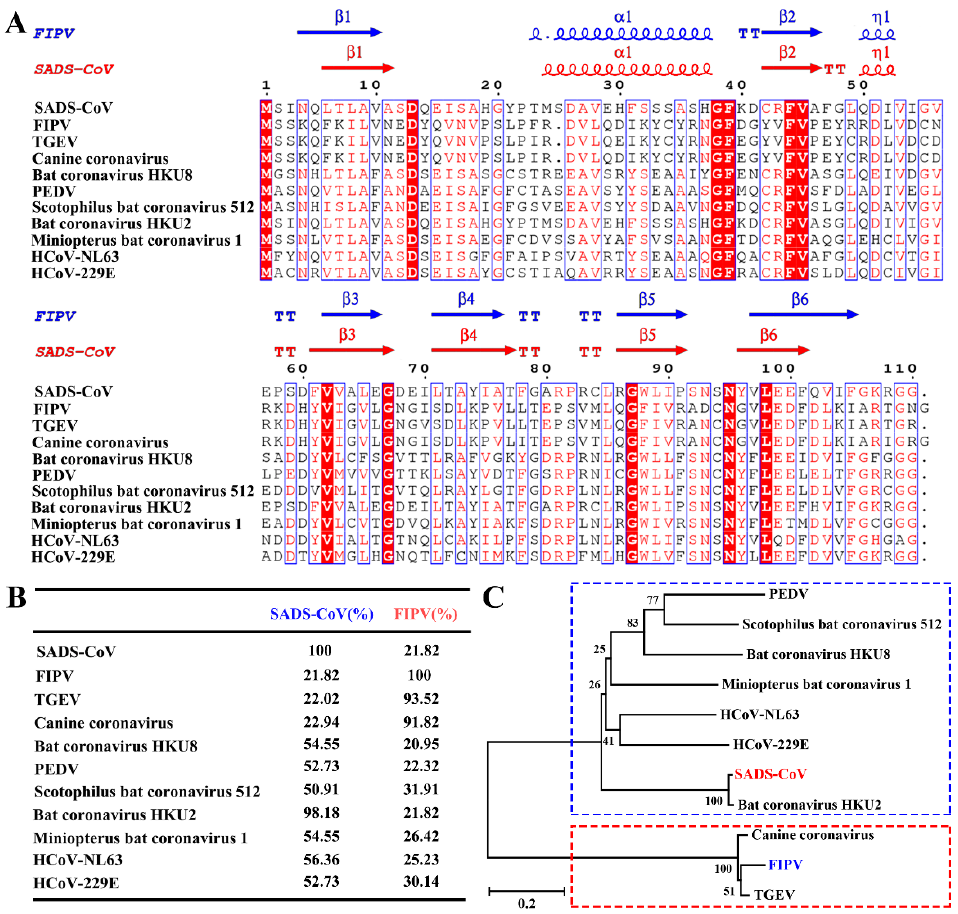
Figure 2. Amino acid sequence alignments and phylogenetic relationships of nsp1 proteins from seven betacoronaviruses ( α -CoVs). ( A , B ) Sequence alignment of α -CoV nsp1 homologs to SADS-CoV nsp1 and FIPV nsp1. The following sequences from GenBank were used to create the sequence alignment (marked as labelled, GenBank TM accession number): SADS-CoV, MH539766; FIPV, DQ010921; transmissible gastroenteritis virus (TGEV), HQ462571; Canine coronavirus, KP981644; Bat coronavirus HKU8, NC_010438; porcine epidemic diarrhea virus (PEDV), AJP67455; Scotophilus bat coronavirus 512, NC_009657; Bat coronavirus HKU2, NC_009988; Miniopterus bat coronavirus 1, EU420138.1; HCoV-NL63, AFV53147; and HCoV-229E, CAA49377. The secondary structural elements of SADS-CoV nsp1 (red) and FIPV nsp1 (blue) are marked at the top of the alignment (helices with squiggles, β -strands with arrows, and turns with TT letters). Residues boxed in red are completely conserved. The sequences were aligned with ClustalW2, and the figure was prepared with ESPript3.0. ( C ) Nsp1 protein sequences from α -CoVs were analyzed by the neighbor-joining method using the maximum likelihood algorithm in the MEGA package. Each bootstrap value was determined by 1000 replicates. The scale bar represents the relationship between the line lengths and sequence